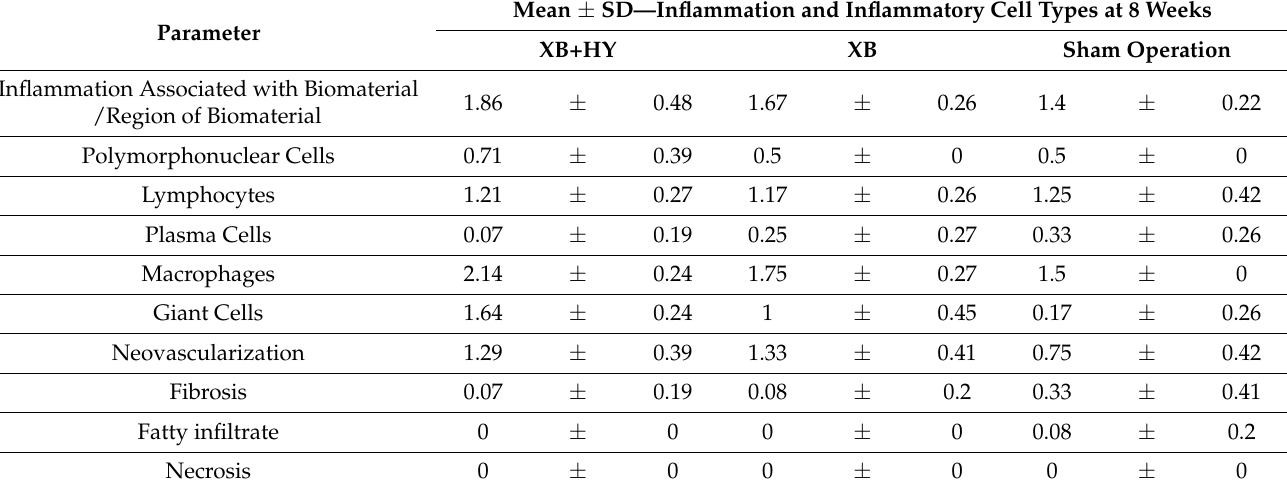
Table 2. Results of the scoring evaluation at 8 weeks post